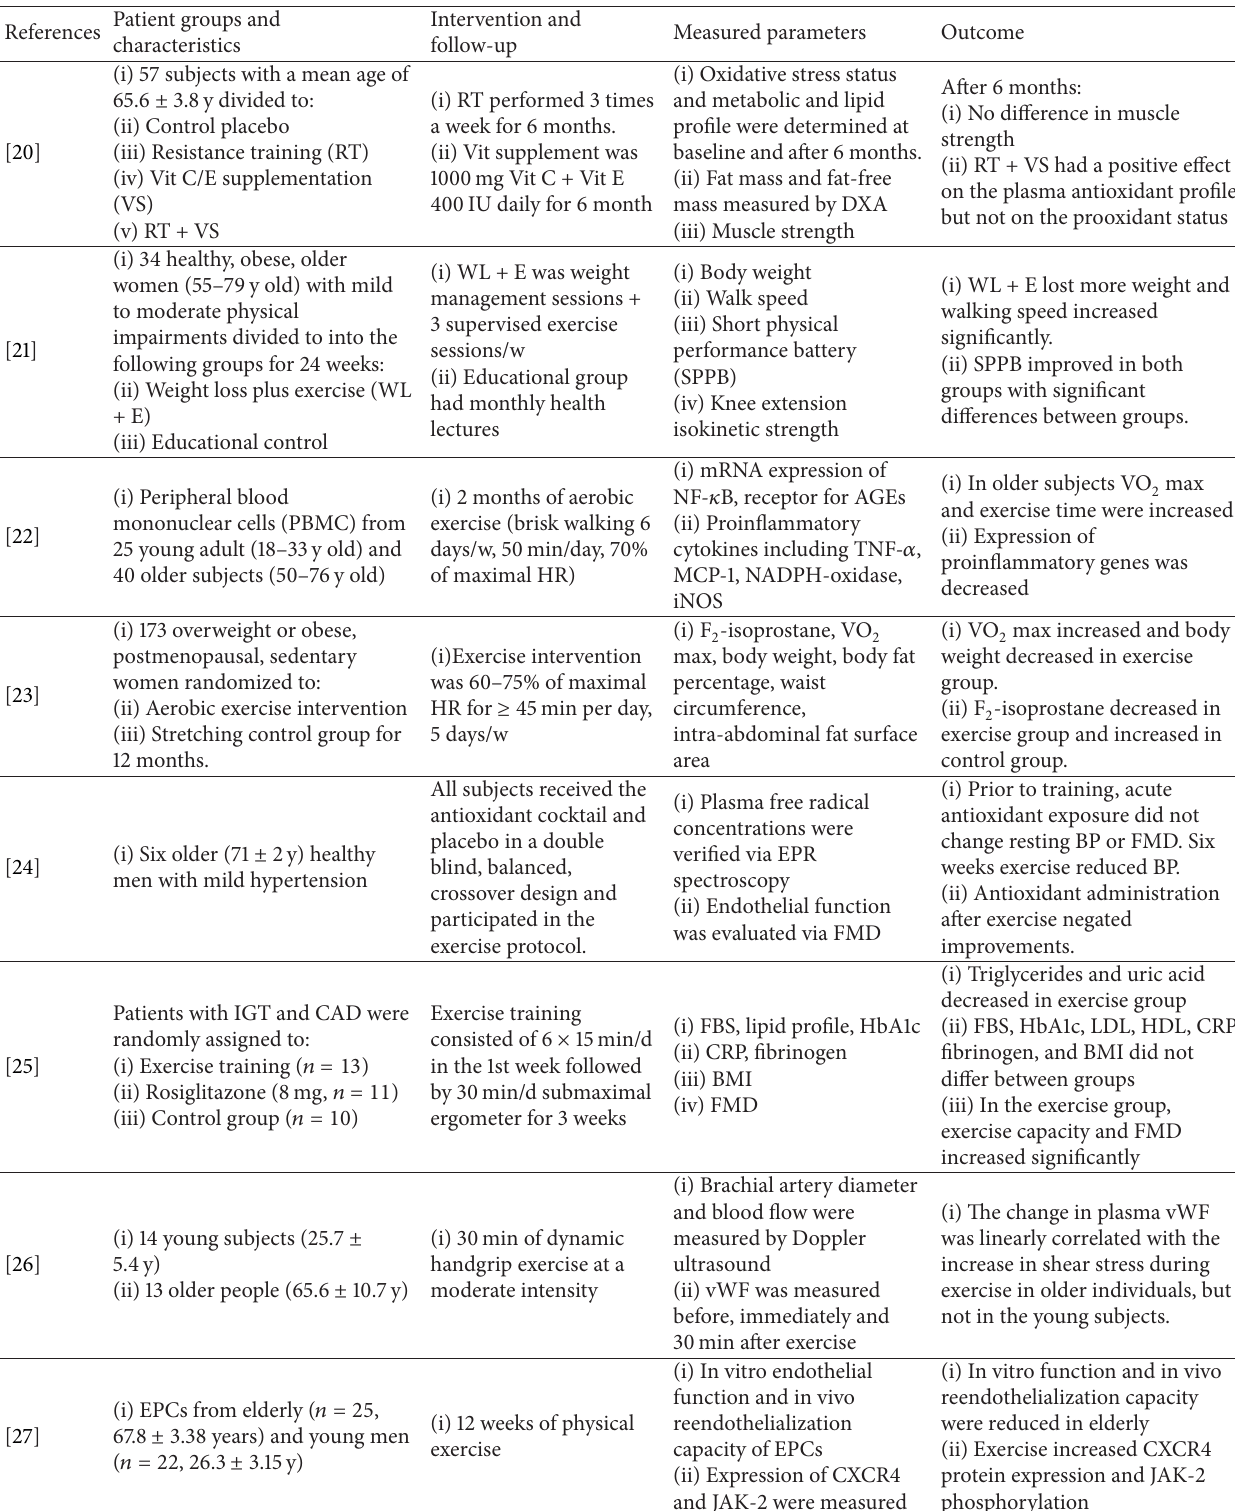
Table 1: Selected recent clinical trials (last 5 years) about the effects of exercise in